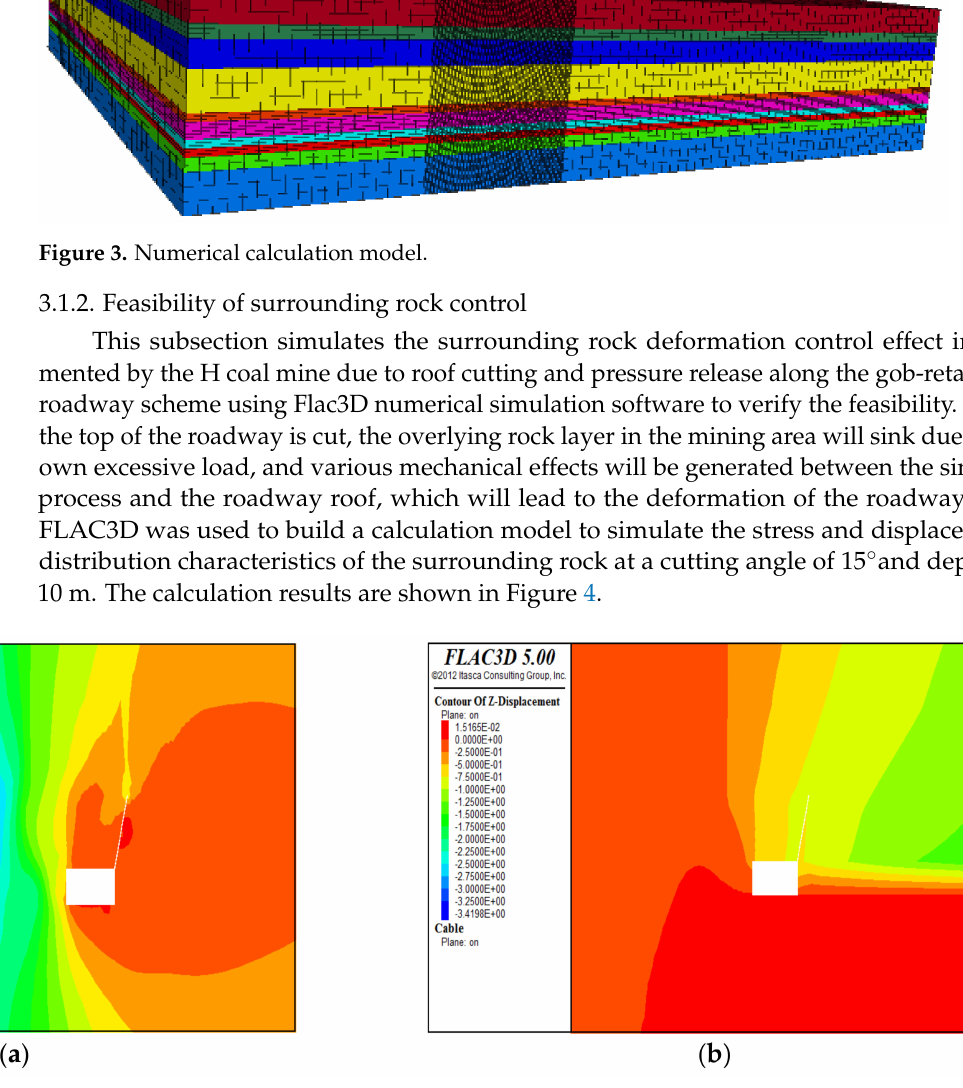
Figure 4. Vertical stress and displacement of 15 ◦ slit: ( a ) vertical stress distribution diagram; ( b ) verti- cal displacement distribution